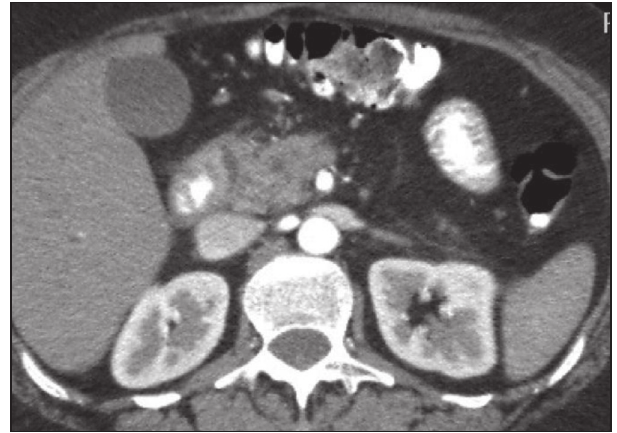
Figure 2) Image from contrast-enhanced computed tomography demon- strating increased soft tissue within the pancreaticoduodenal groove, thicken- ing of the wall of the duodenum and fluid attenuation within the thickened duodenal wall. The pancreatic head is heterogeneous and contains calcifica- tions. There is a tight regular stricture of the distal common bile